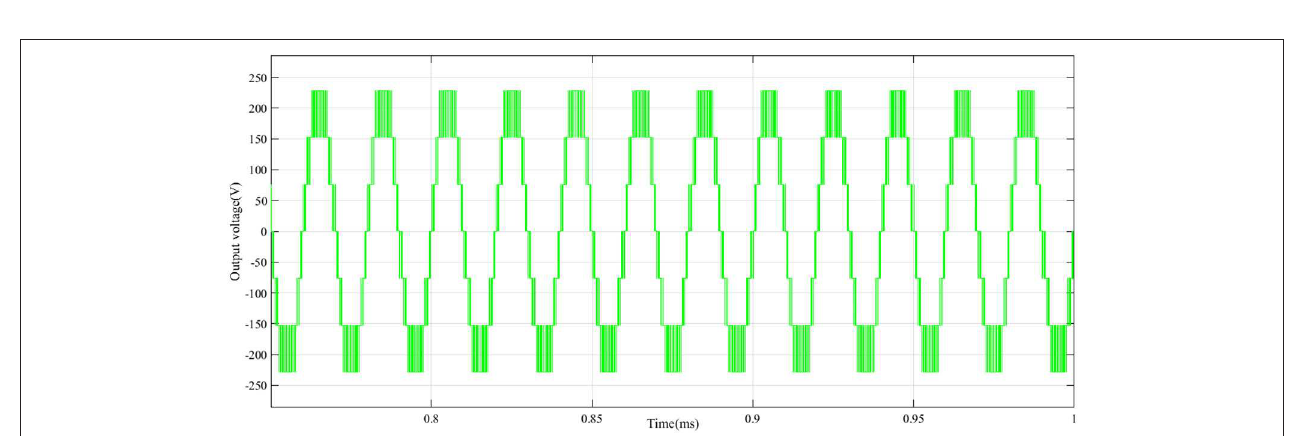
FIGURE 6 | Seven-level output voltage from seven-level inverter with five switches.